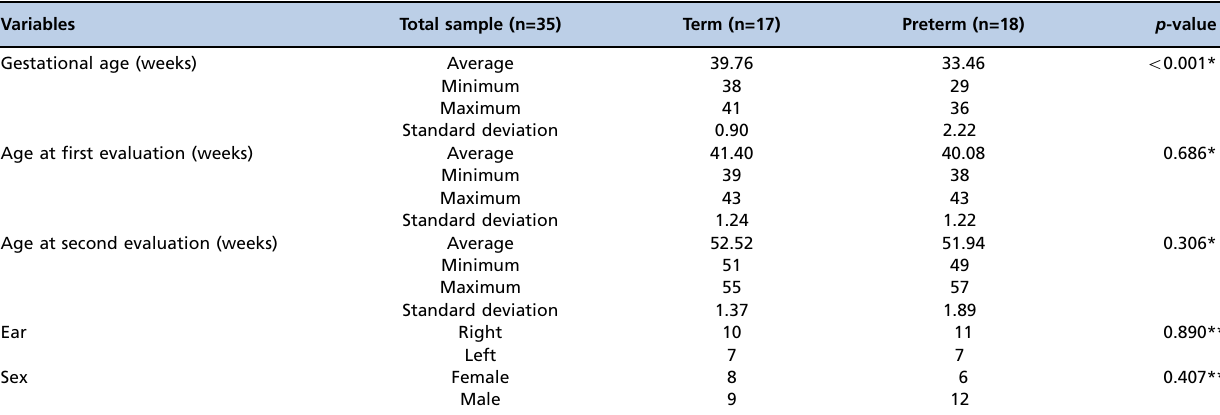
Figure 1 - Example of cortical potential P1 in the first (superior images) and third months of life (inferior images). Table 2 - Characterization of the